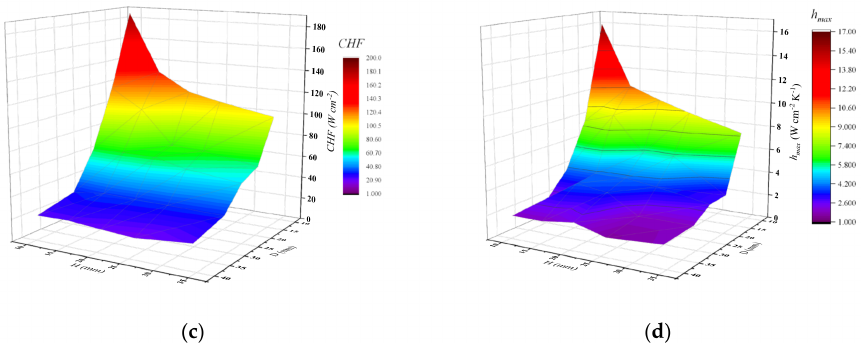
Figure 10. Variations of the distributions of CHF and h max at different mass flow rates. ( a ) CHF distribution at high mass flow rate; ( b ) h max distribution at high mass flow rate; ( c ) CHF distribution at low mass flow rate; ( d ) h max distribution at low mass flow rate.